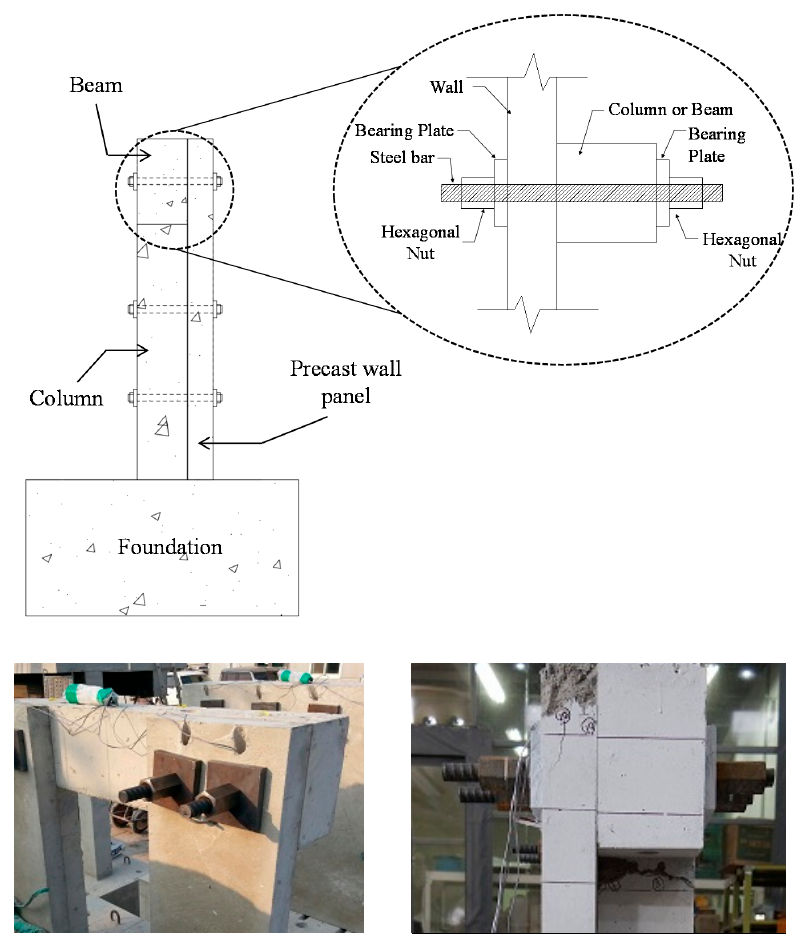
Figure 2. Details of externally anchored precast wall